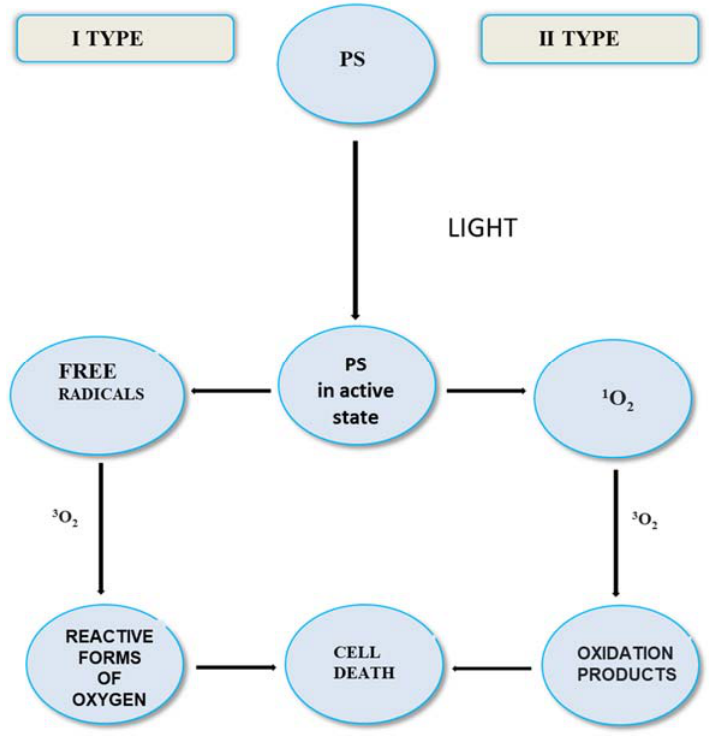
Figure 3. Scheme of the course of the reaction in PDT.